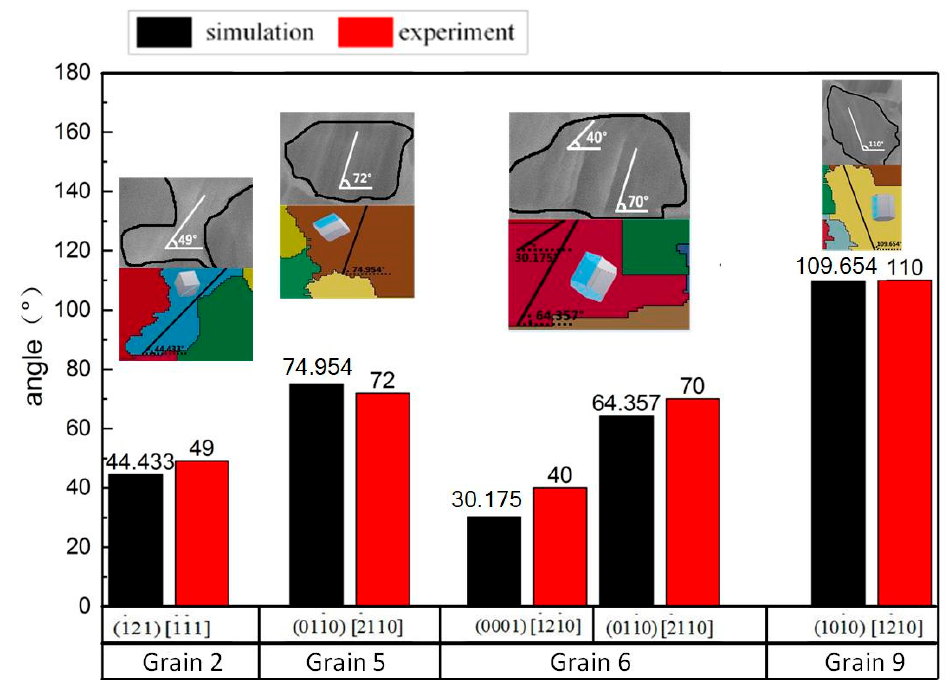
Figure 6. Comparison of slip traces between simulation and experiment of the slip systems activated in different grains (the gray figures were SEM images, and the color figures are simulation results).